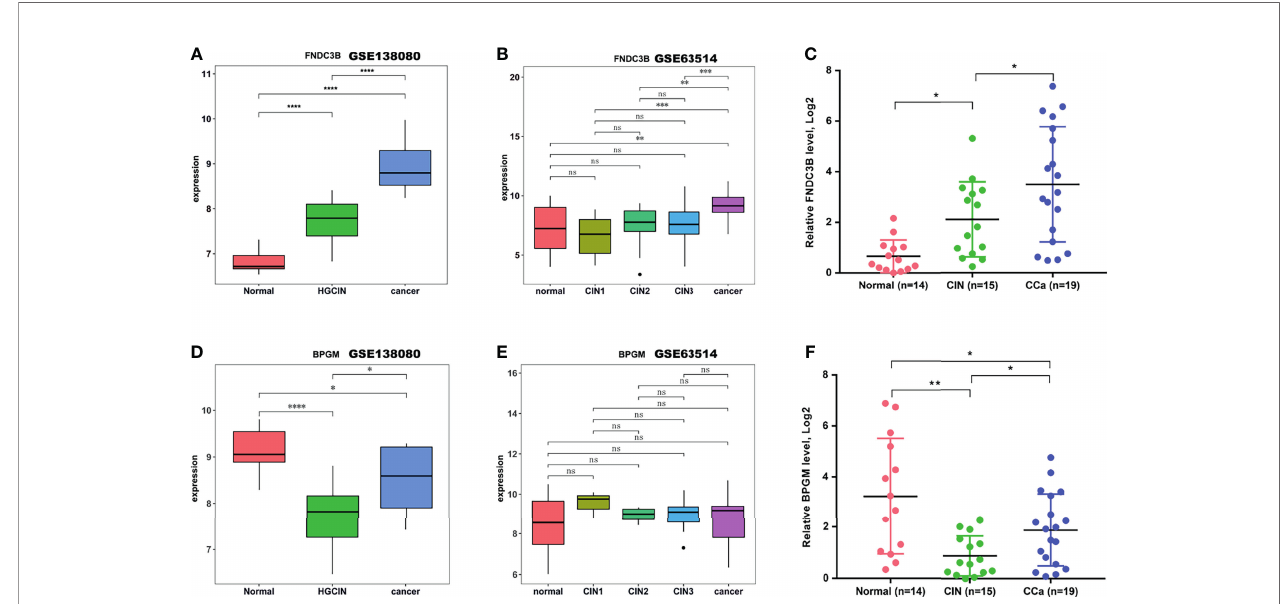
FIGURE 5 | FNDC3B and BPGM expression analysis. (A, B) The expression of FNDC3B analyzed in the test dataset GSE138080 and in the validation dataset GSE63514. (C) The expression of FNDC3B assessed using qRT-PCR in clinical specimens. (D, E) The expression of BPGM analyzed in the test dataset GSE138080 and in the validation dataset GSE63514. (F) The expression of BPGM assessed using qRT-PCR in clinical specimens. *p < 0.05, **p < 0.01, ***p < 0.001, ****p < 0.001, ns, not signi fi